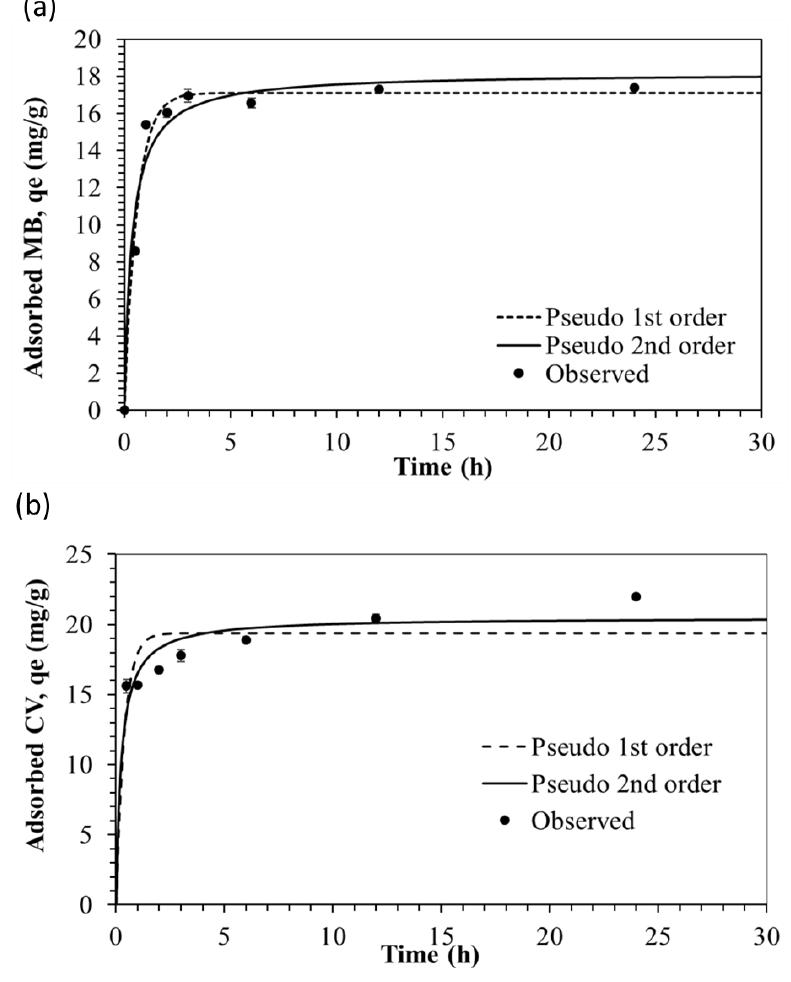
Figure 3. The kinetic profile represented by the pseudo-first order and pseudo-second-order for ( a ) methylene blue (MB) adsorption and ( b ) crystal violet (CV) adsorption